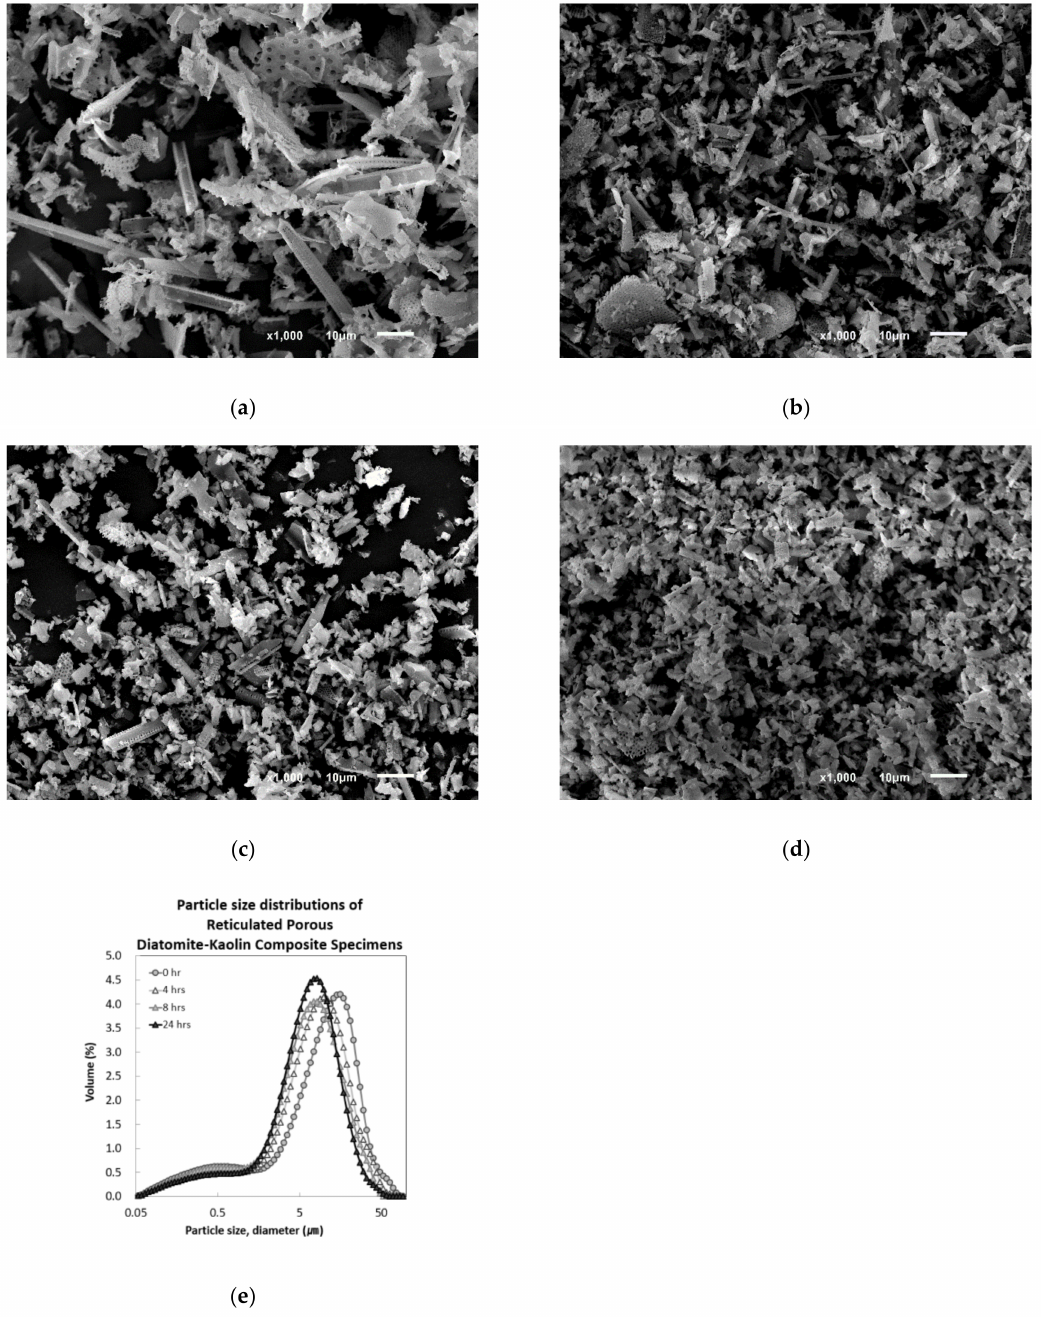
Figure 2. Scanning electron microscopy (SEM) images of diatomite particles ball milled for ( a ) 0 h (as-received), ( b ) 4 h, ( c ) 8 h, and ( d ) 24 h; ( e ) particle size distributions of diatomite particles ball-milled for 0, 4, 8, and 24